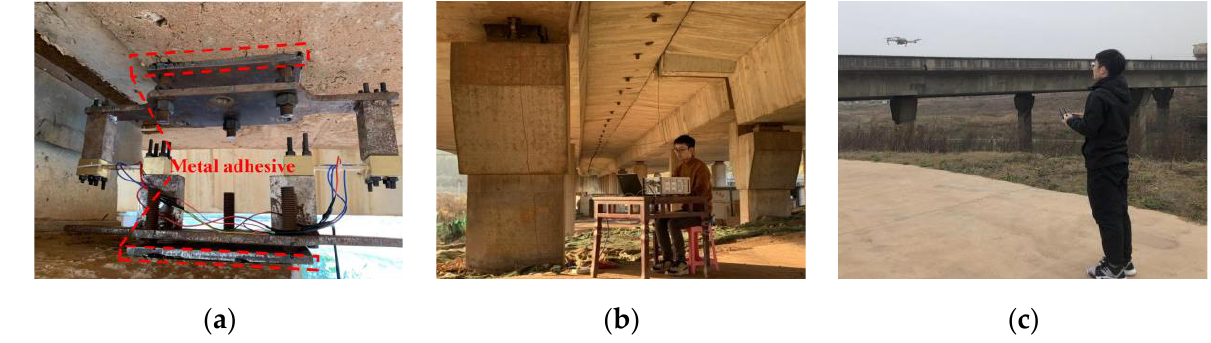
Figure 13. On-site installation of BRT-1 rotation monitoring device ( a ) device installation; ( b ) overall setup; ( c ) UAV photography.